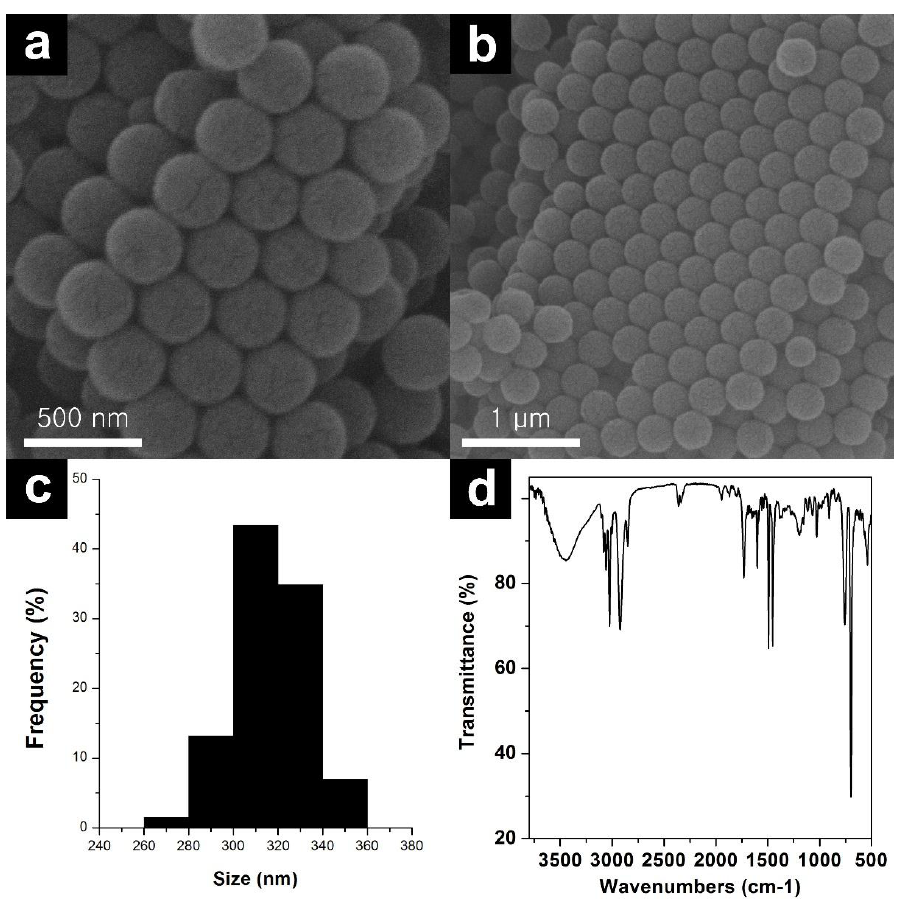
Figure 1. SEM images ( a , b ); size distribution ( c ) and FT-IR spectra ( d ) of PS spheres.